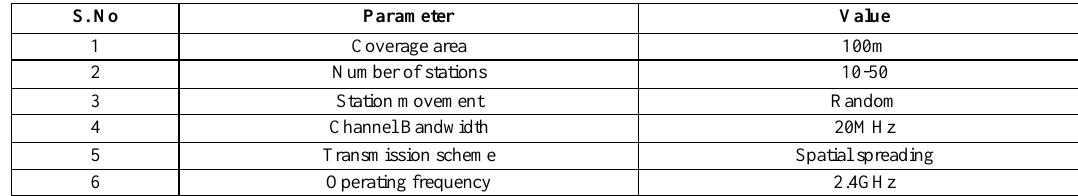
Table 1. Simulation parameters